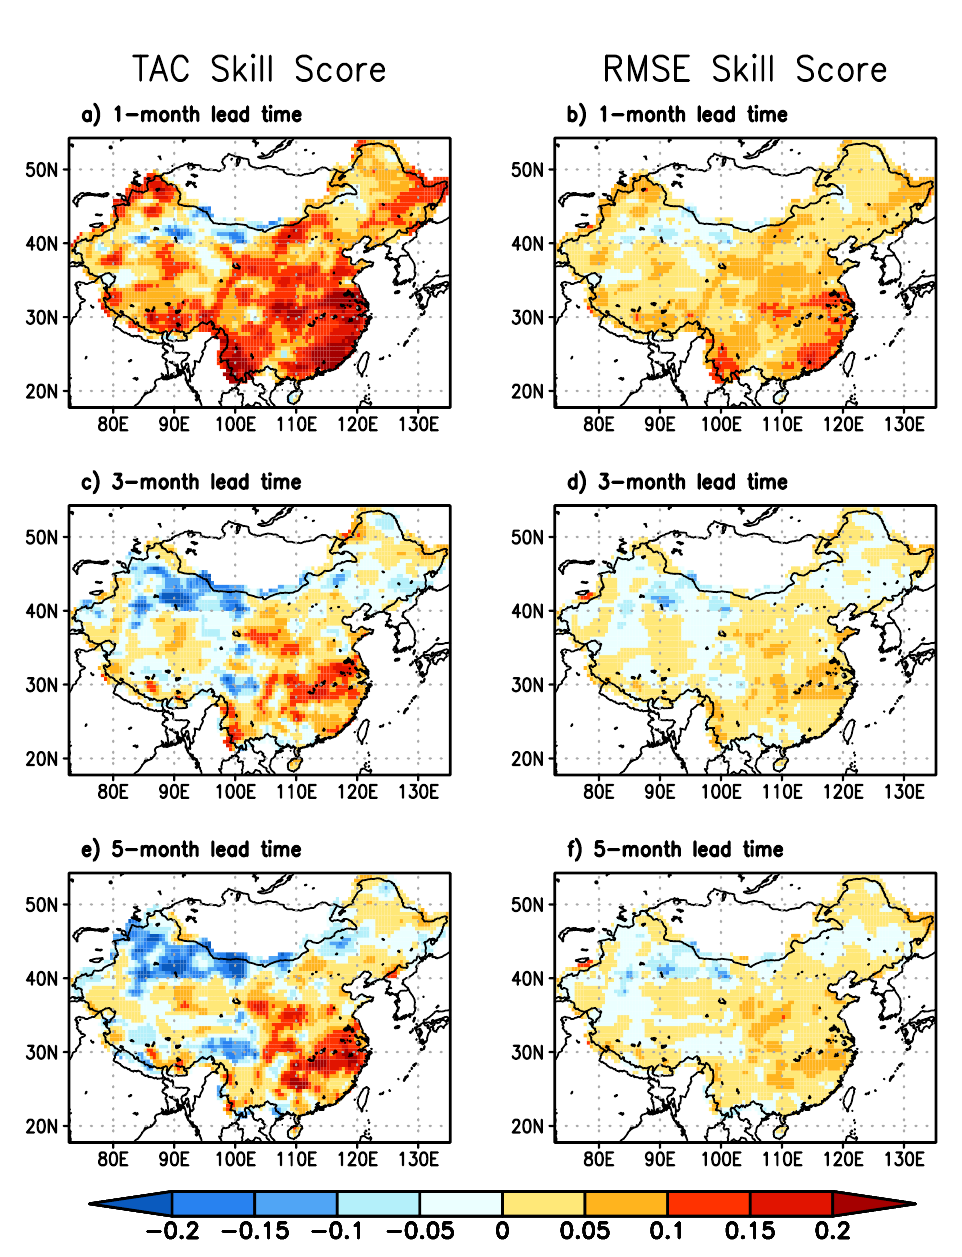
Figure 3. Similar to Figure 1 but showing the skill scores of temporal anomaly correlation (TAC) and root mean square error (RMSE) for the CFSv2 forecast at three different lead times with the six-month standard precipitation index (SPI6) persistence forecast as the reference